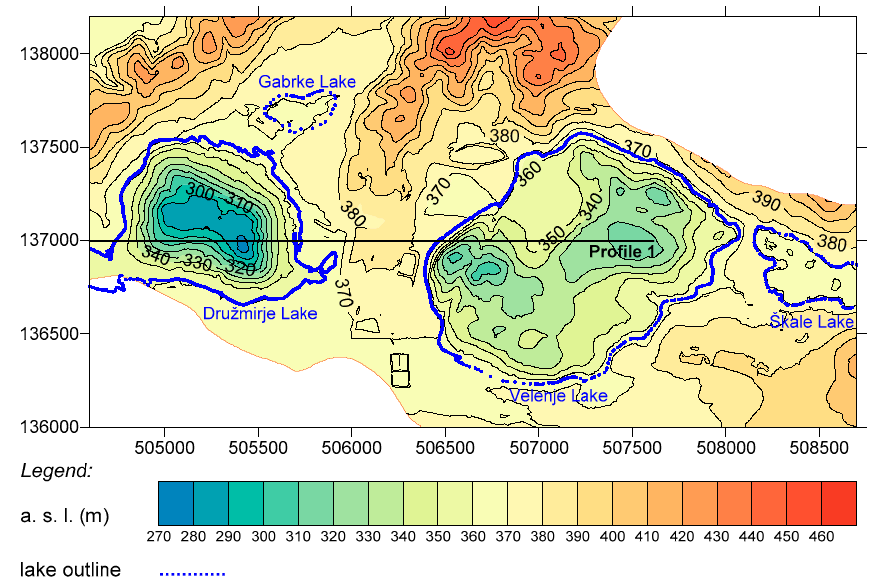
Figure 3. Studied area with coal layer occurrence limits and location of Profile 1.